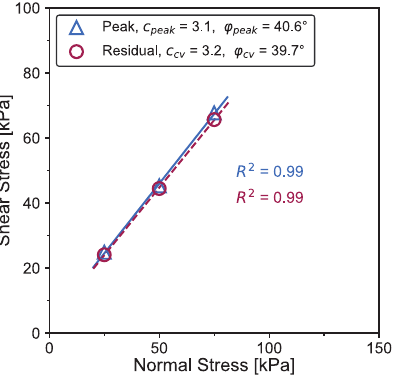
Figure 6. Direct shear test results of JEZ-1: ( a ) shear stress and ( b ) vertical strain as a function of horizontal displacement.